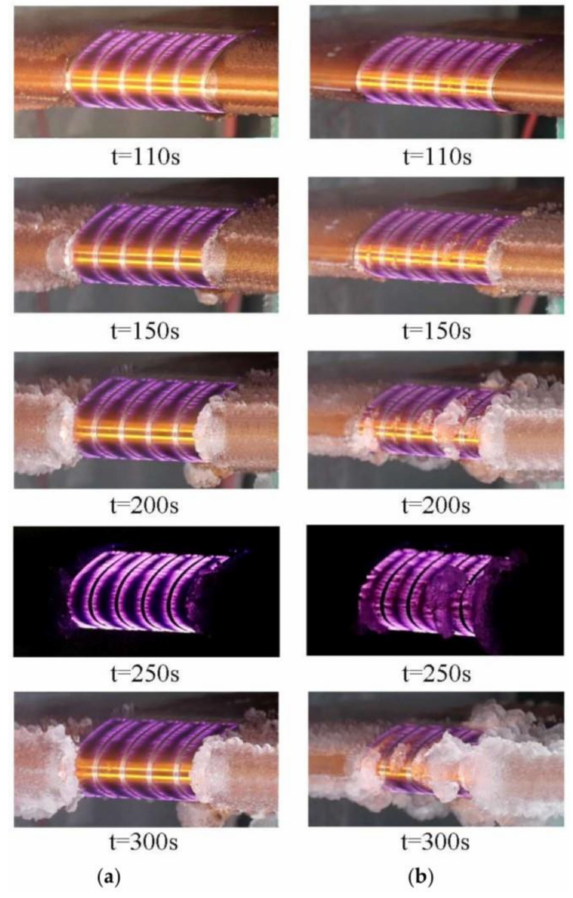
Figure 17. Dynamic anti-icing process of NS-DBD plasma actuator: ( a ) LV-HF discharge and ( b ) HV-LF discharge (adapted from Chen et al. [177] under the Creative Commons Attribution